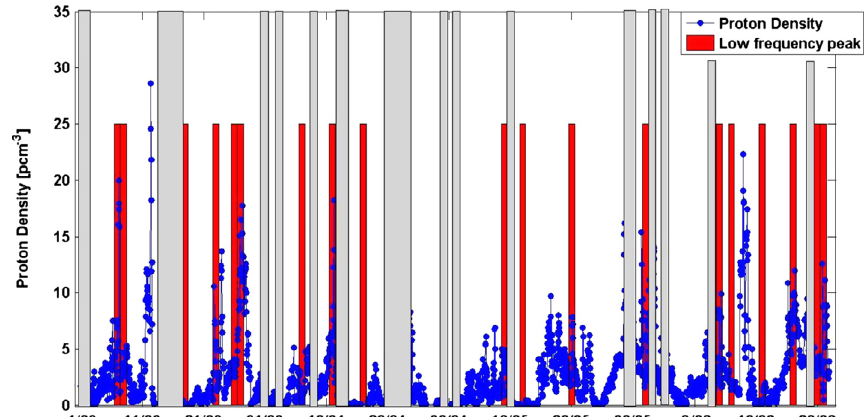
Figure 9. Occurrence of low frequency J z peak plotted alongside ACE solar wind proton density. Red bars – days with low frequency peak, blue points – ACE solar wind proton density measurements. Gray rectangles mark non fair weather